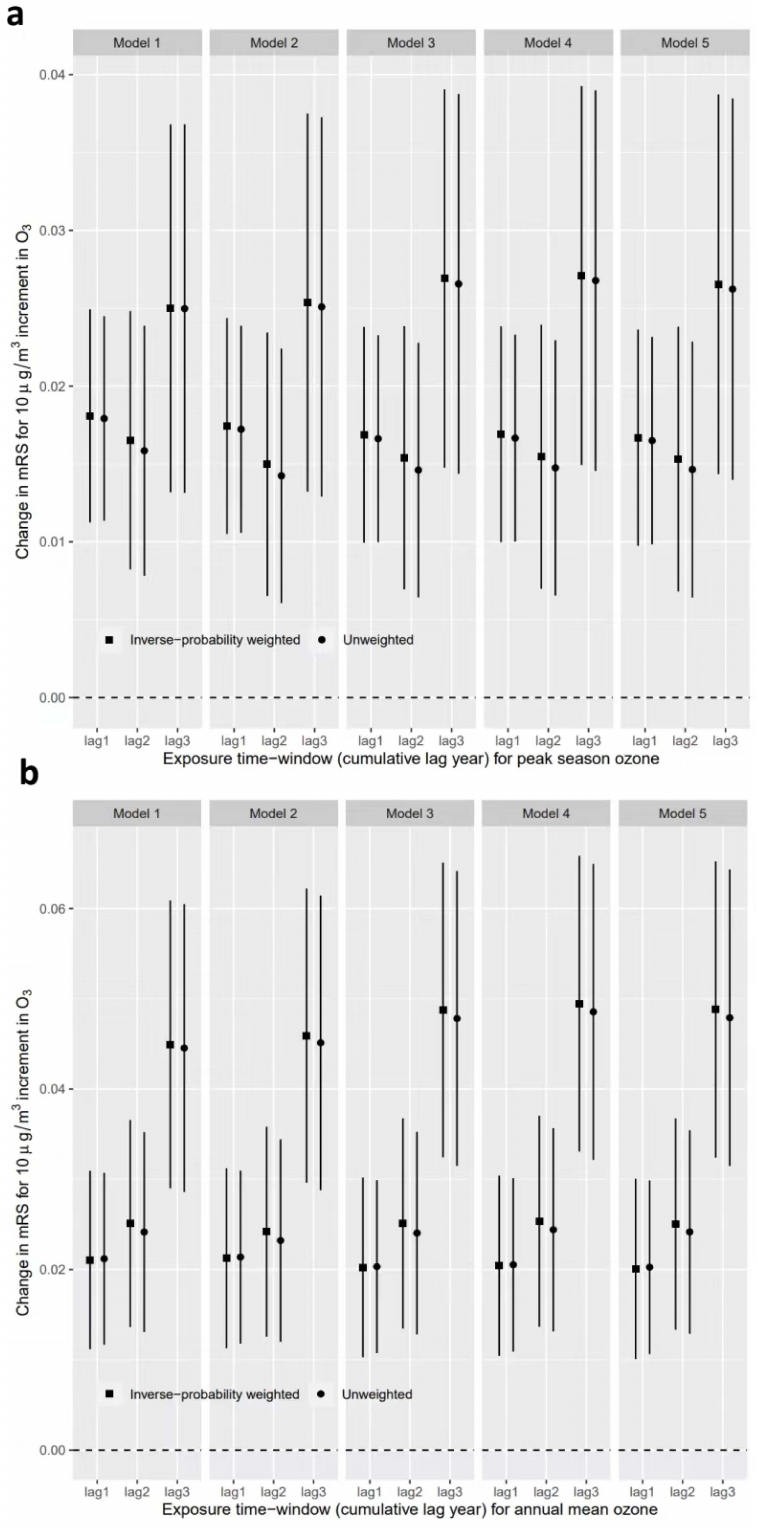
Figure 2. Associations of O 3 exposure with mRS score using different exposure time windows. ( a ) Peak-season O 3 . ( b ) Annual mean O 3 . Models were adjusted for the interaction of the follow-up period with age at baseline, the interaction of follow-up period with years after stroke at baseline, season of the study, smoking, drinking, physical activity, milk intake, body mass index, hypertension, diabetes, dyslipidemia, and atrial fibrillation. mRS, modified Rankin